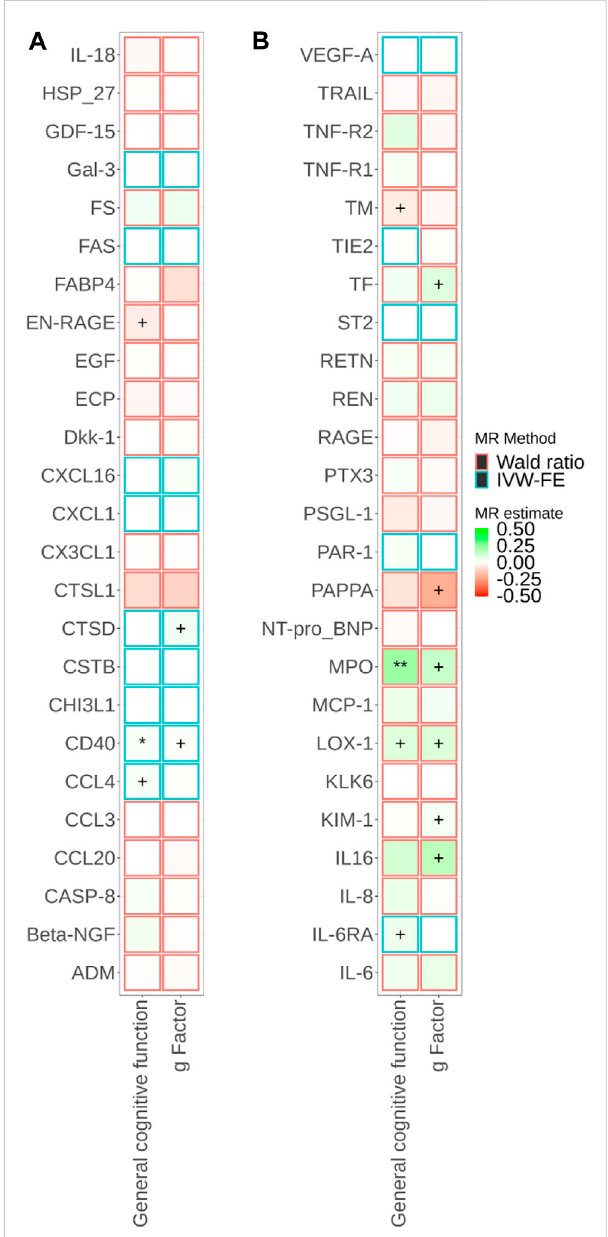
FIGURE 3 Associations of brain-speci fi c cis -eQTL-predicted plasma protein concentrations with cognitive traits from Mendelian randomisation (MR). MR estimate was obtained from the Wald ratio method (N SNP = 1) and inverse-variance weighted (IVW) method (N SNP > 1). The symbol + indicates an association with a p -value smaller than0.05, thesymbol*indicates anassociationwith a p -valuesmaller than 0.05/90, and the symbol ** indicates an association with a p -value smaller than 0.05/180. Due to the large number of proteins, MR results for different proteins are presented in Panels a and b in this fi